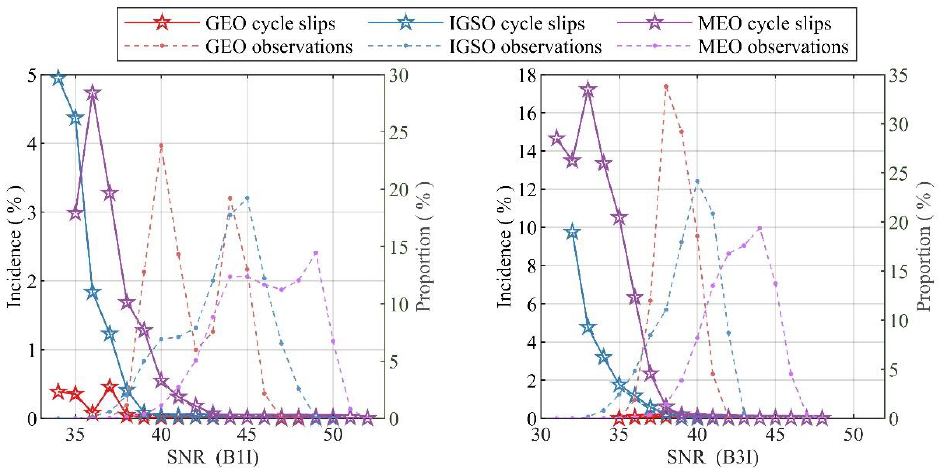
Figure 12. The relationship among cycle-slip incidence, SNR, and orbit.